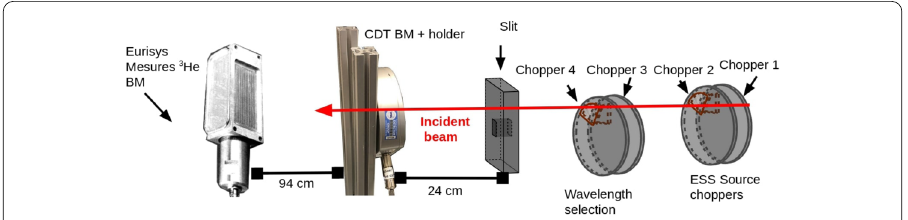
Figure 5 Experimental setup at the V20 beam line. The incident beam (red) passes from right to left through two sets of choppers and a set of (x,y) slits before hitting the I-BM. The attenuated beam is monitored with a reference Eurisys Mesures 3 He beam